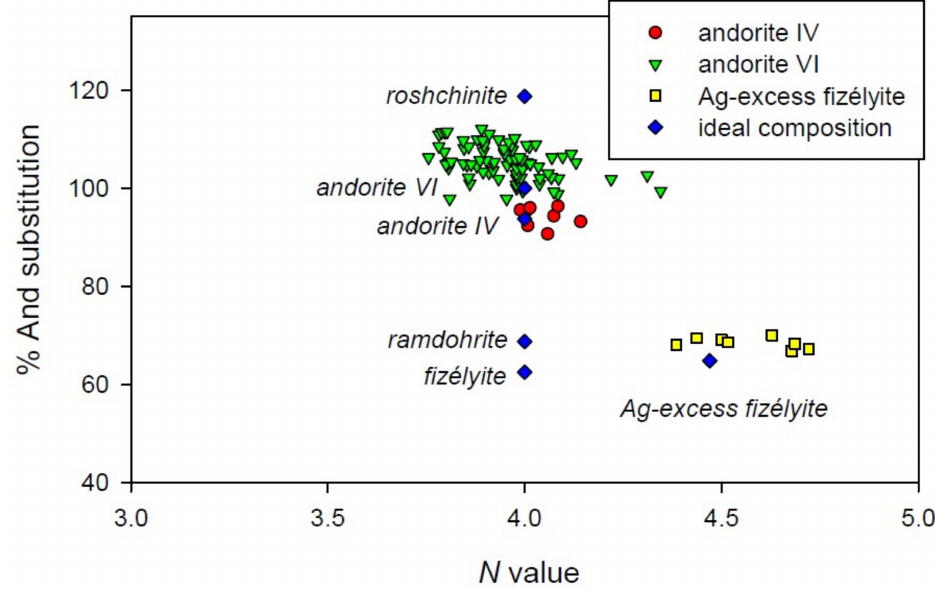
Figure 23. Graph of N value vs. % of And substitution for members of the andorite branch from the Kremnica deposit.